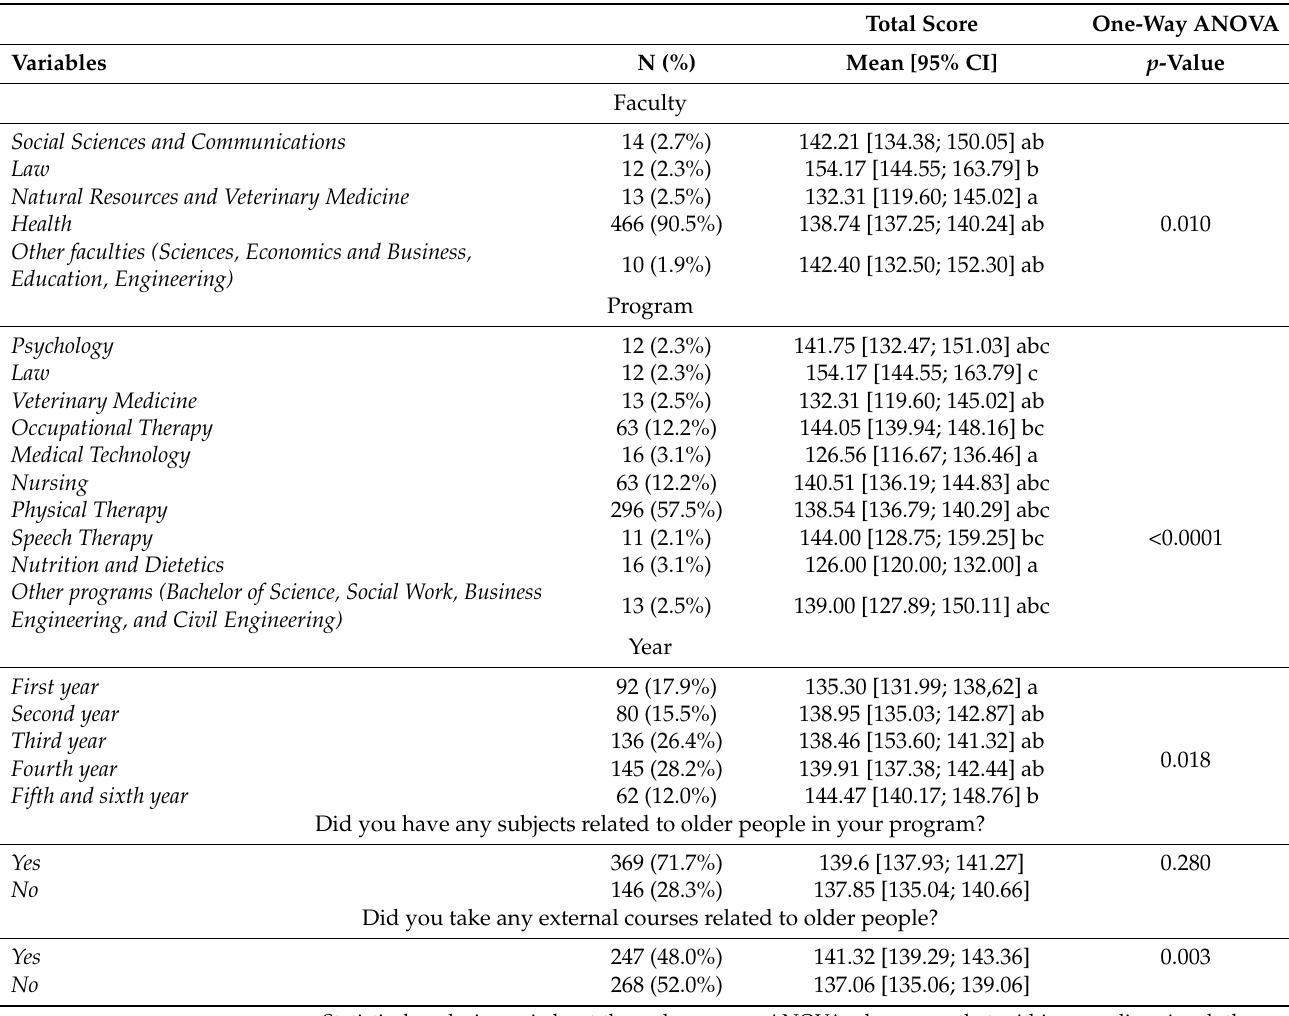
Table 3. Educational